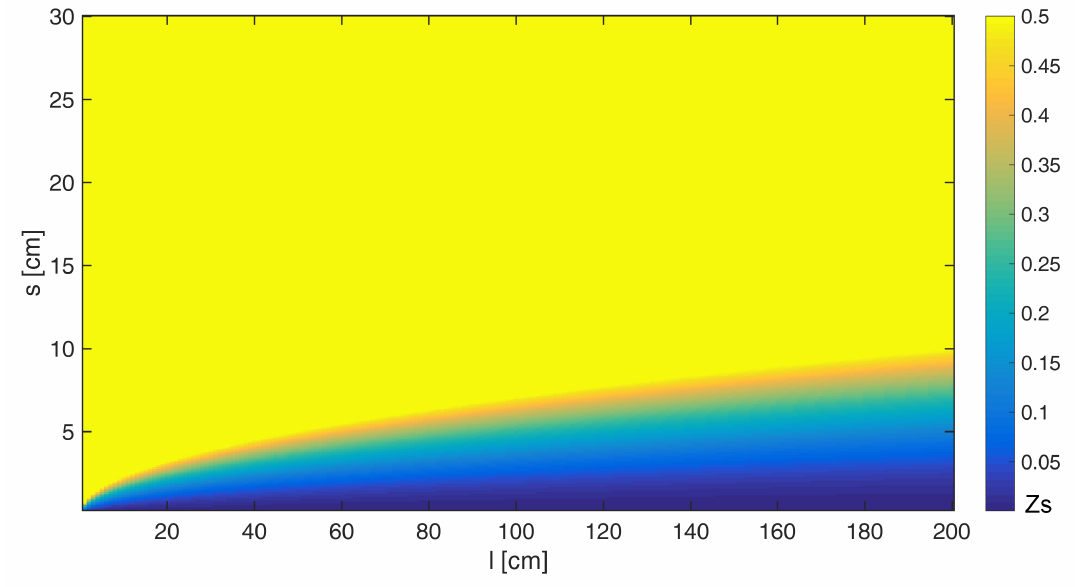
Figure 9. Numerical simulation of variations of the roughness parameter Zs with changes in roughness height s and correlation length l .